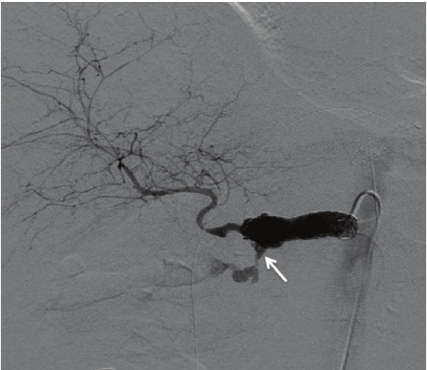
Figure 3: Angiography shows rebleeding from a distal site apart from the first bleeding site (arrow).